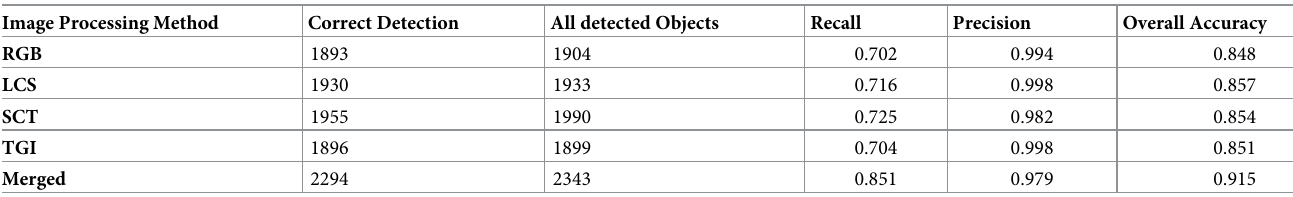
Table 5. Detection performance on ROI of 50m altitude